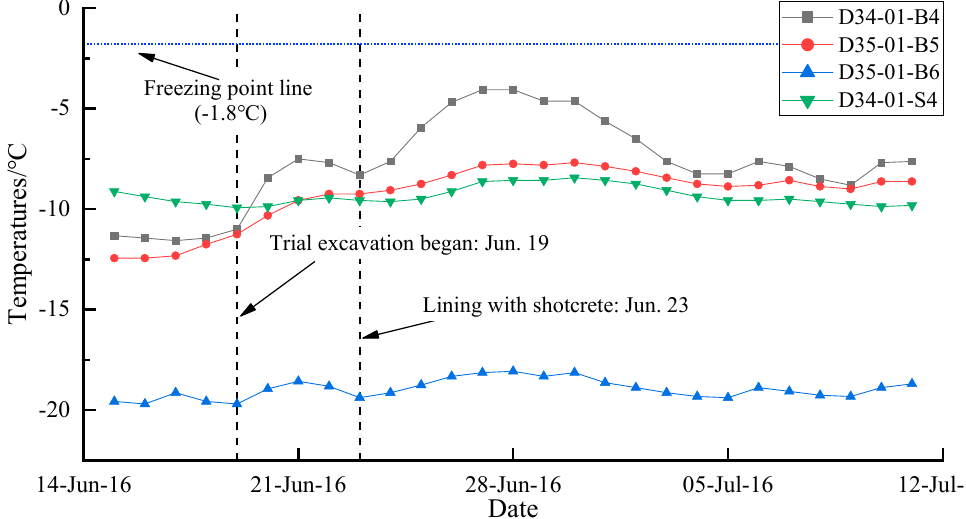
Figure 8. Temperature variation with time of measuring points at area A3 (see Figure 4).